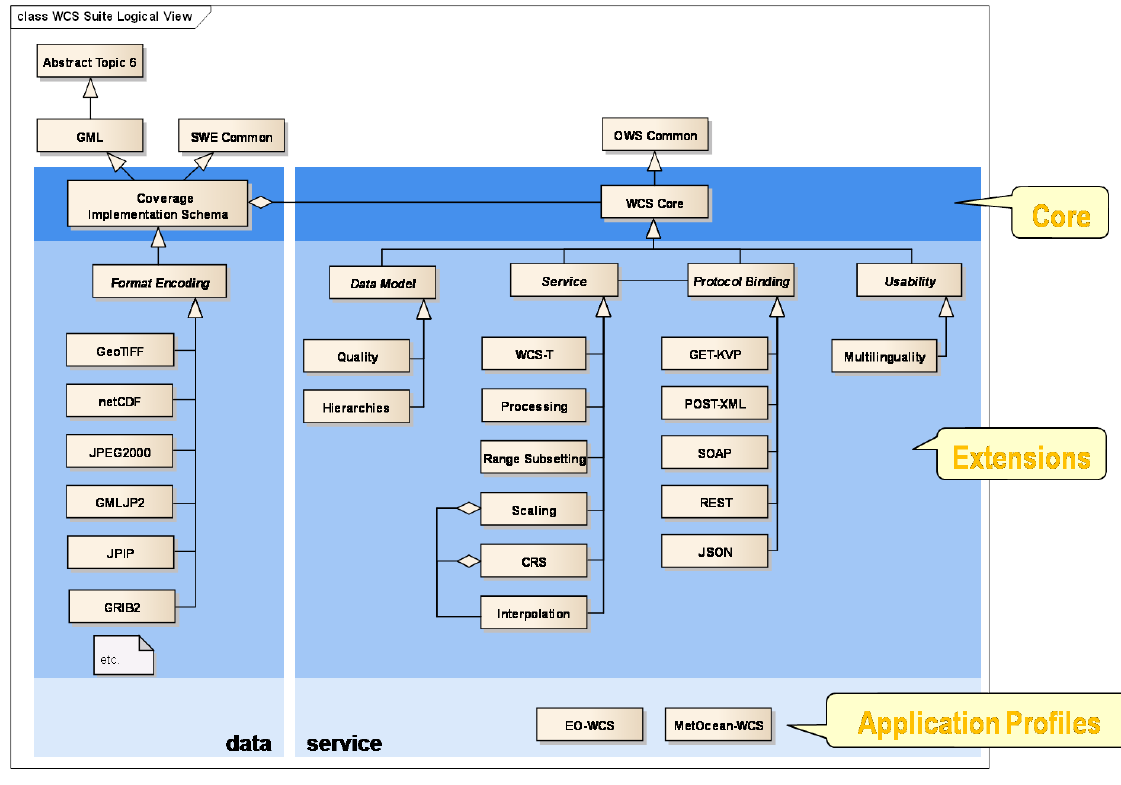
Figure 4. WCS modular data and service